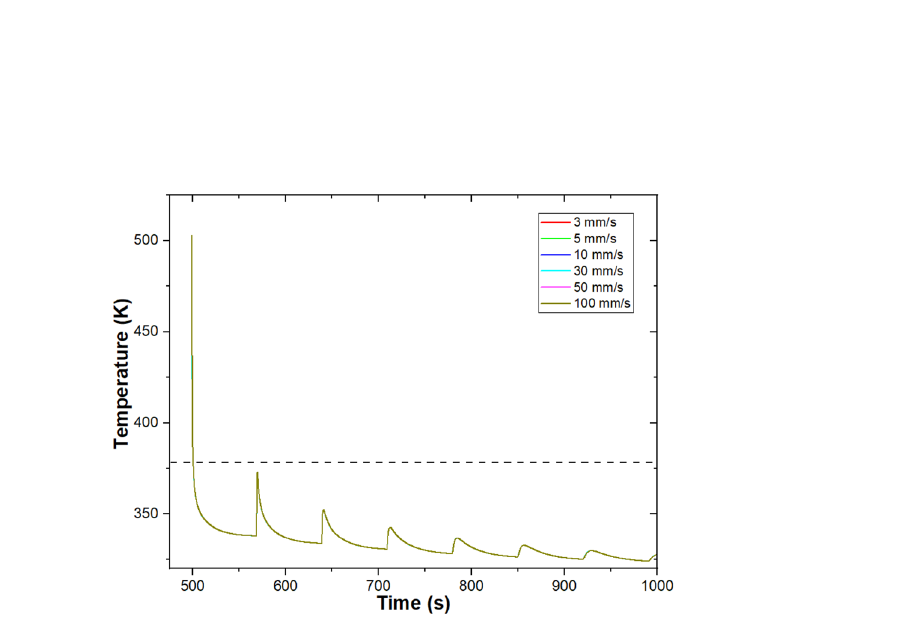
Figure 5. Modeled temperature of layer 9 of a single-road width wall printing at a range of v print and a constant layer time of 70 s. Wall was modeled with T ext = 230 °C and h = 0.3